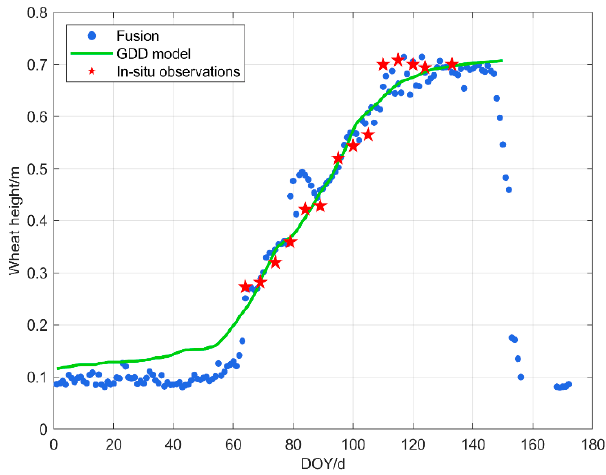
Figure 12. Fusion wheat height retrieval.